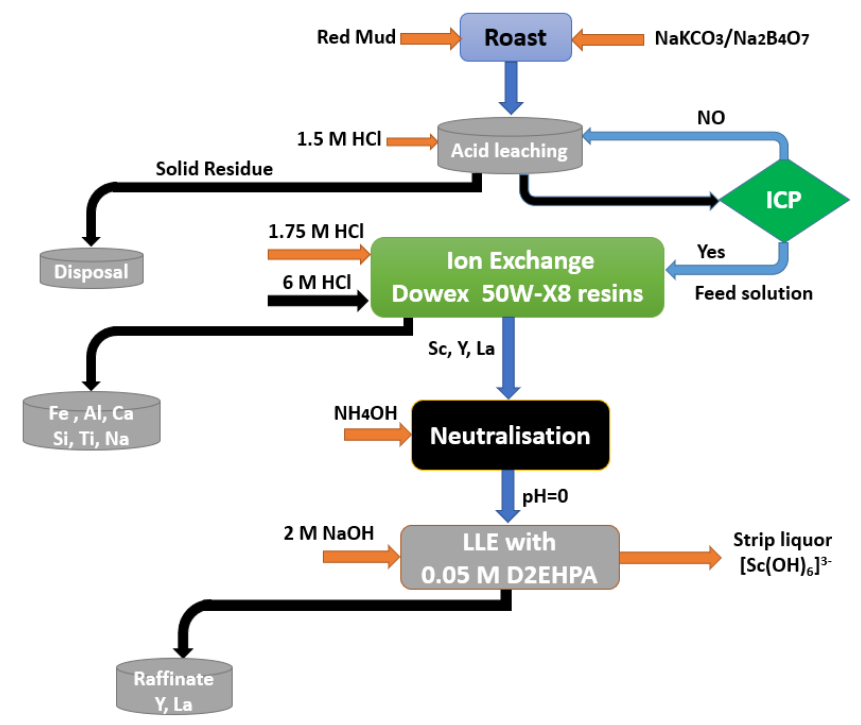
Figure 19. The proposed flow-chart of scandium separation from RM, adapted from [1,151]. The dried RM powder was sintered with sodium potassium carbonate and sodium tetraborate at 1100 ◦ C for 20 min, dissolved in concentrated hydrochloric acid (1:1), and then diluted with 1.5 mol/L hydrochloric acid. A chromatographic column (IX) loaded with Dowex 50 W-X8